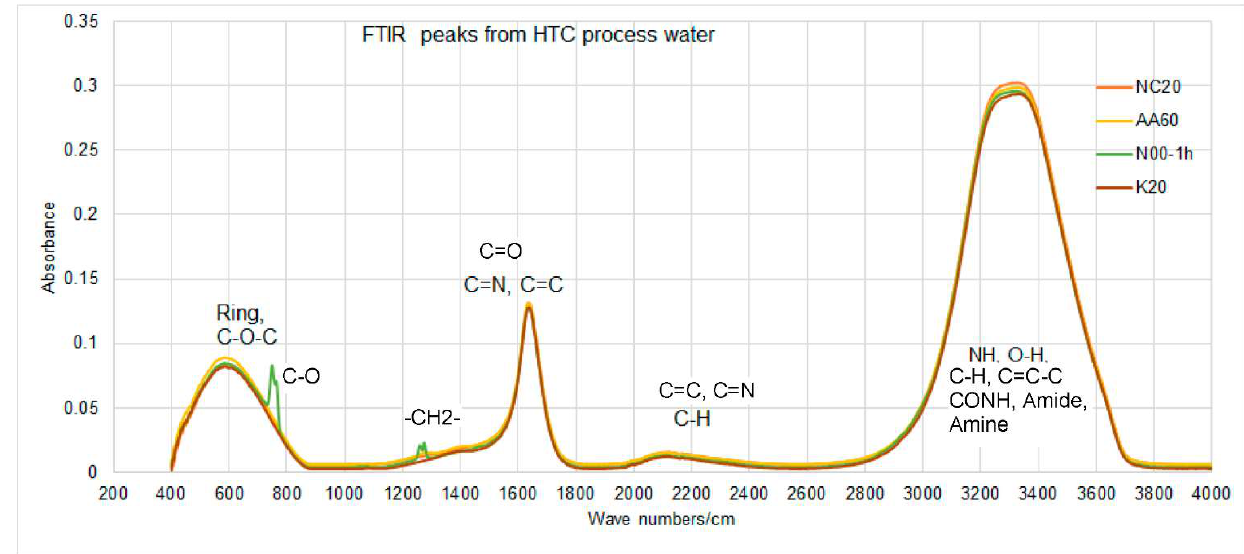
Figure 1. FTIR micrographs from HTC-PLs at different HTC conditions. Table 2. Absorbance range and possible functionals providing FTIR peaks.